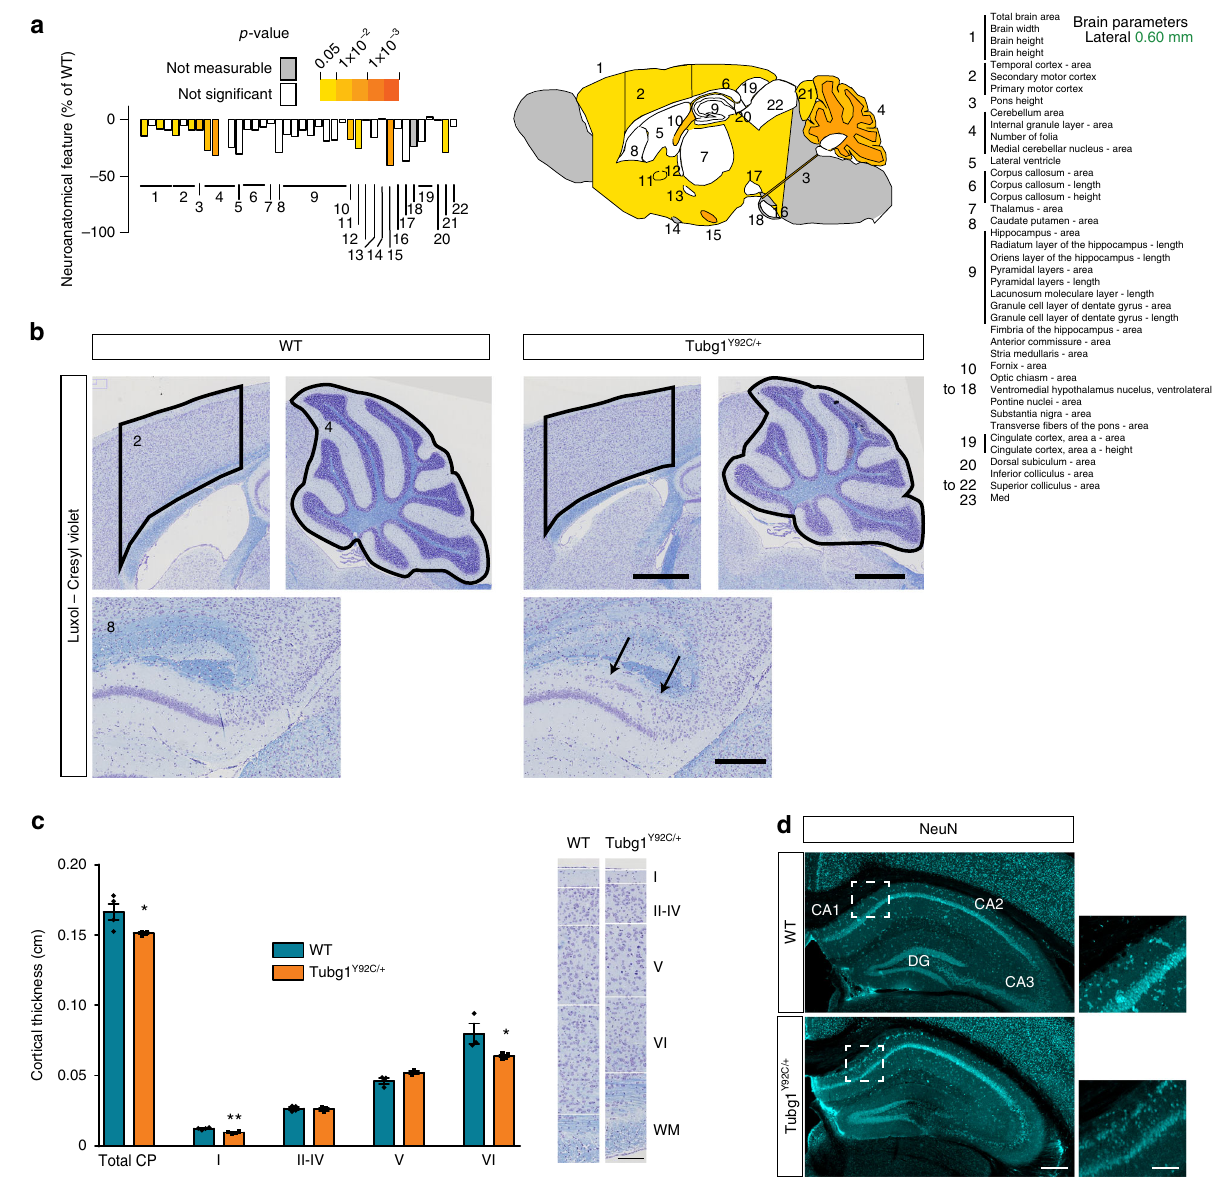
Fig. 6 Microcephaly and abnormal hippocampal organization in Tubg1 Y92C/ + mice. a Schematic representation of affected brain regions plotted in sagittal planes according to p -values. The right image represents a section at Lateral + 0.60 mm. White coloring indicates a p -value higher than 0.05 and gray shows not enough data to calculate a p -value. Histograms are showing the percentage decrease (minus scale) in size of measured brain regions as compared to the controls (100%). Numbers indicate assessed brain regions listed on the right; n = 4 16-weeks-old male mice per group. b Sagittal sections of the hippocampus, the cortex and the cerebellum from control WT and Tubg1 Y92C/ + adult mice stained with cresyl violet/luxol blue. Black arrows indicate the hippocampal heterotopia. Scale bar 0.1 cm (upper panels), 200 µ m (lower panel). c Cortical layers analysis (left panel) performed in sections of the secondary motor cortex in control WT and Tubg1 Y92C/ + adult mice stained with cresy violet/luxol blue, n = 4 mice per group, unpaired t -test, * p < 0.05, ** p < 0.01. Data are presented as mean ± s.e.m. Source data are provided in the Source Data fi le. Representative images showing layers defects (right panel). Scale bar 150 μ m. d Coronal sections of the hippocampus from control WT and Tubg1 Y92C/ + adult mice stained with NeuN, scale bar 300 µ m. Higher magni fi cation view of the region delimited with dotted square is shown on the right of each image, scale bar 100 µ